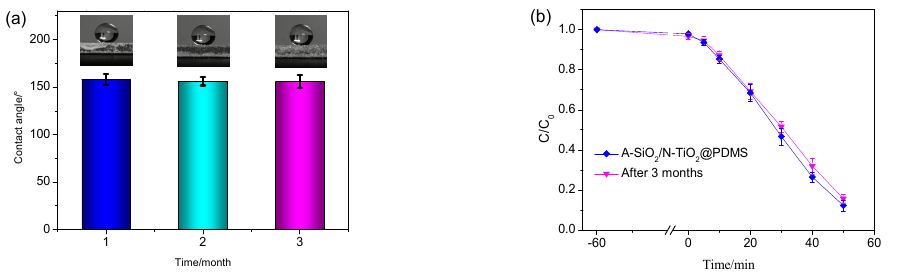
Figure 6. The changes in ( a ) WCAs and ( b ) photocatalytic degradation effects of the A-SiO 2 /N-TiO 2 @PDMS coating after being placed outdoors for 3 months.